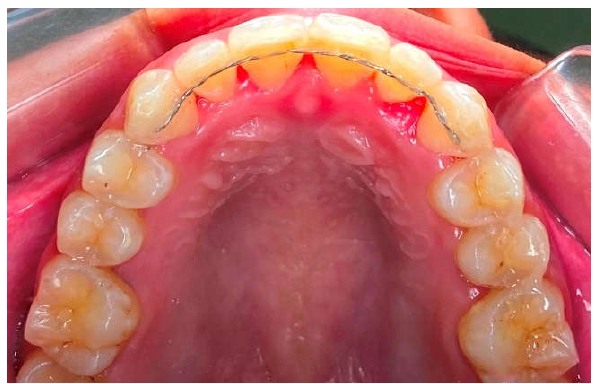
Figure 1. Fixed bonded retainer.